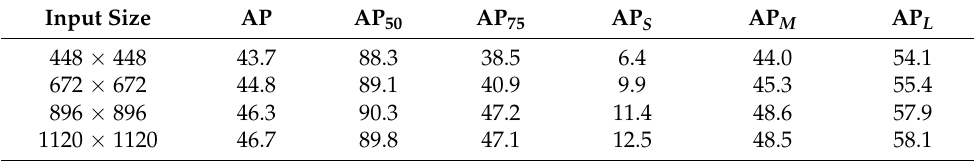
Table 5. Performance comparison of F-Transformer on input images of different resolutions.